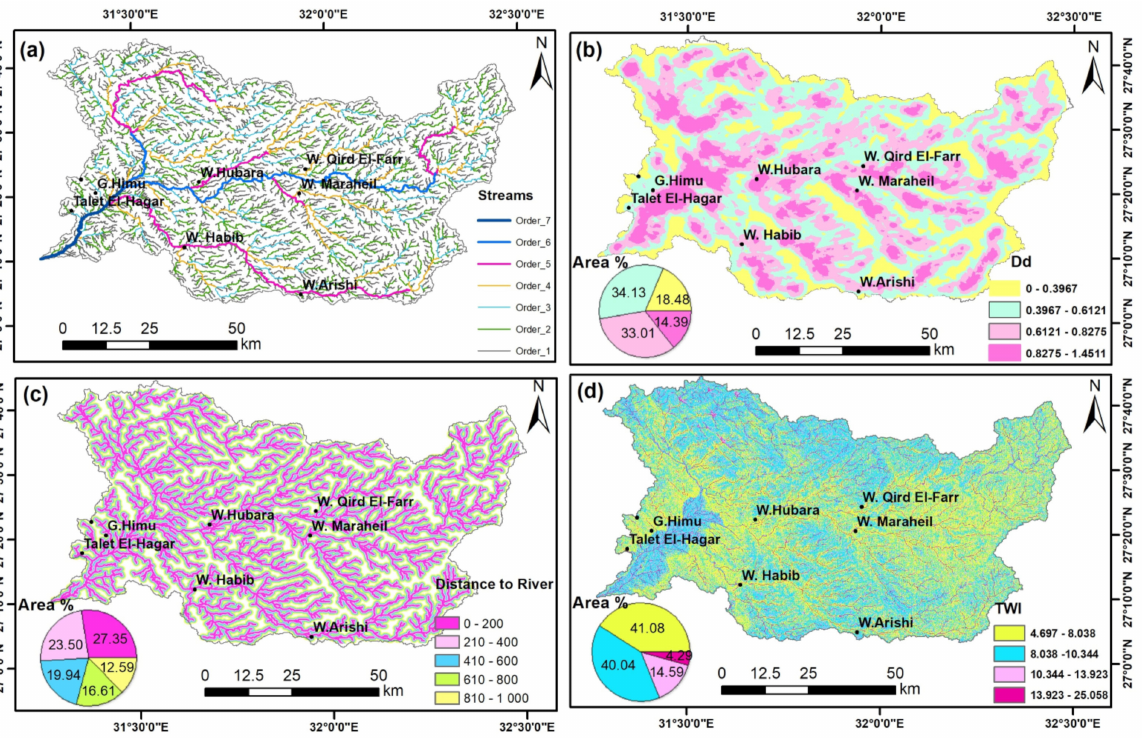
Figure 6. Hydrological factors: ( a ) stream-network order; ( b ) drainage density; ( c ) distance to river; ( d ) TWI